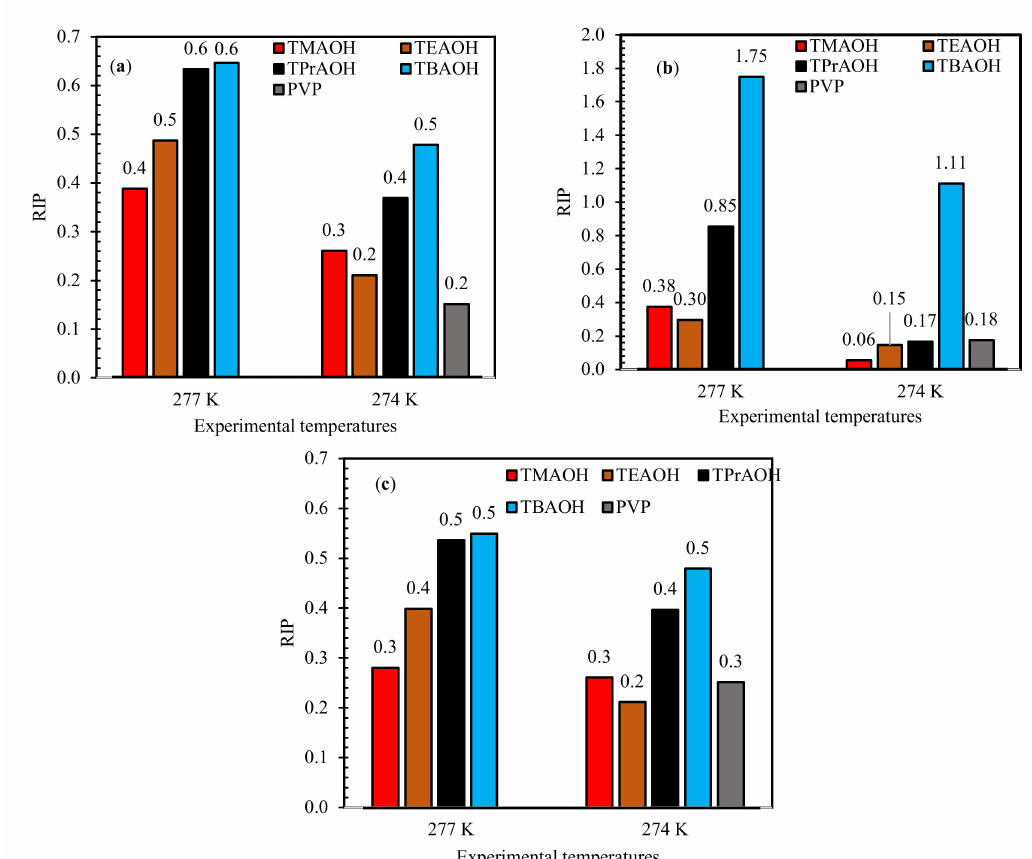
Figure 2. Influence of 1 wt% QAHs on relative inhibition power (RIP) of mixed gas hydrates at different experimental temperatures for ( a ) 70% CH 4 + 30% CO 2 , ( b ) 50% CH 4 + 50% CO 2 , and ( c ) 70% CH 4 + 30% CO 2 , and comparison with commercial inhibitor